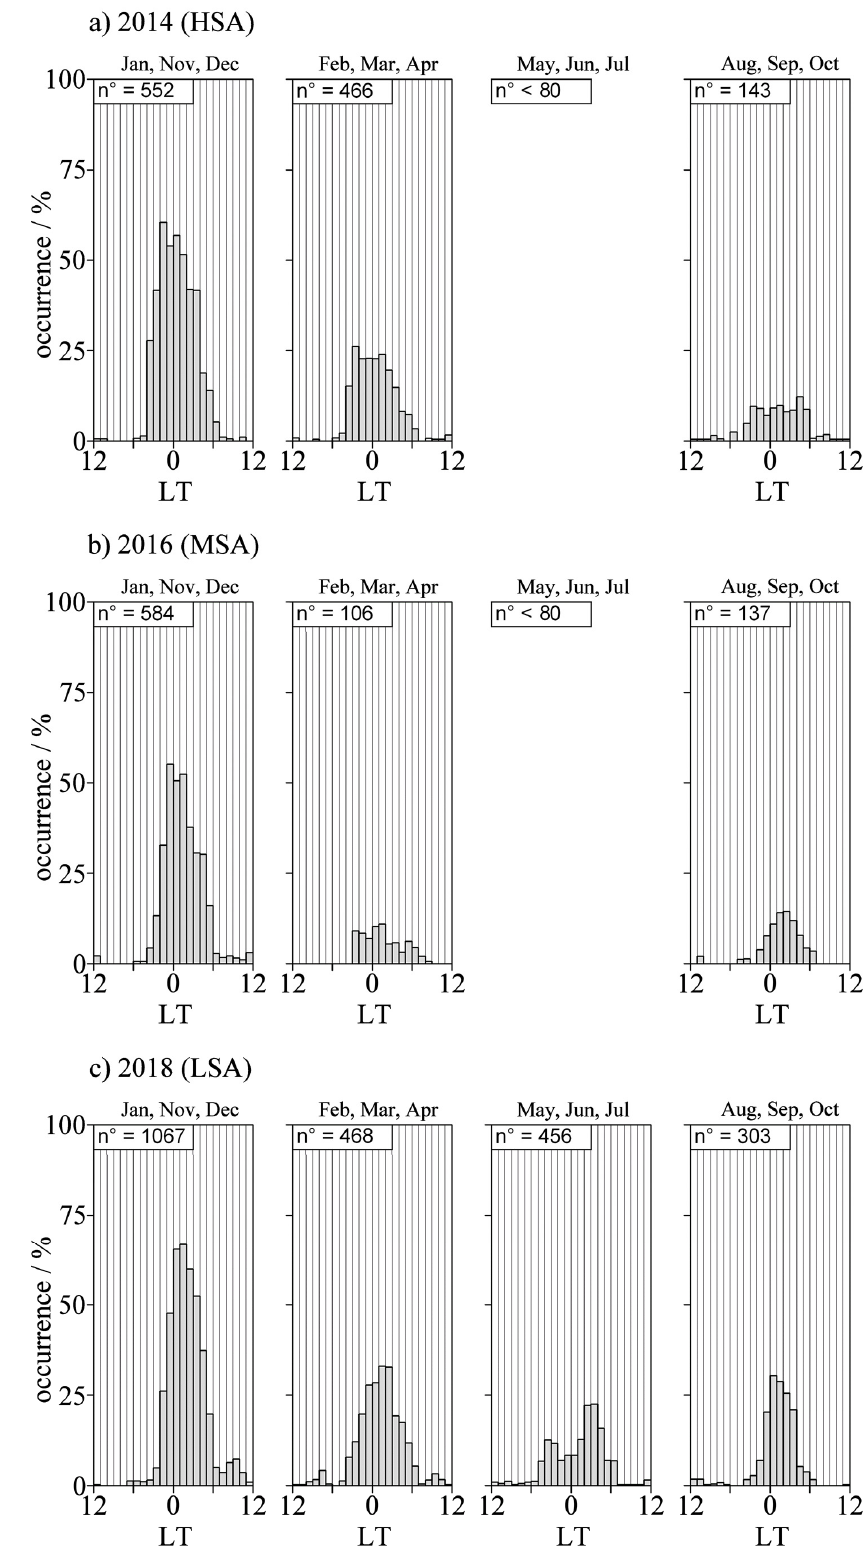
Figure 2. The occurrence of spread F as a function of LT in 2014 (HSA) ( a ), 2016 (MSA) ( b ), and 2018 (LSA) ( c ), for a p < 7. Only the histograms derived from more than 80 cases of spread F are shown.